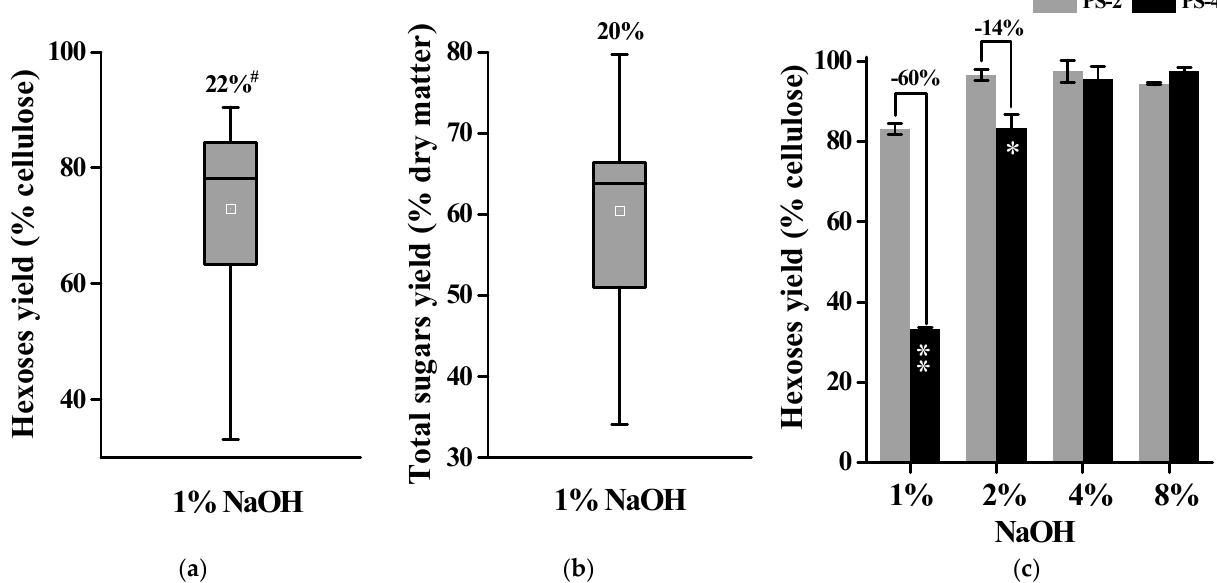
Figure 3. Variation of biomass enzymatic saccharification among 11 total banana samples after alkali pretreatments ( n = 11). ( a ) Hexoses yields released from enzymatic hydrolysis after 1% NaOH pretreatment; ( b ) total sugar yields (hexoses and pentoses) released from both enzymatic hydrolysis and 1% NaOH pretreatment; ( c ) hexoses yields released from enzymatic hydrolysis after four concentrations of NaOH pretreatments with two banana samples; # As coefficient of variation. * and ** indicate significant differences between PS-2 and PS-4 by t -test at p < 0.05 and p < 0.01 ( n ± 3). Minus sign percentage was calculated by subtraction between PS-2 and PS-4 values divided by PS-2. Data as mean SD ( n ± 3).